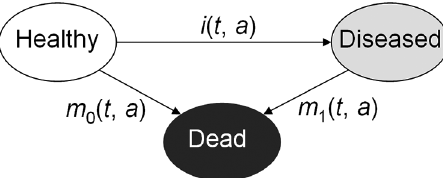
Figure 1. Illness-death model. People aged a at time t in the population are in one of the three states: Healthy , Diseased ,or Dead. Transitionsbetweenthesestatesaredescribed bytherates i , m 0 ,and m 1 ,whichingeneraldepend on t and a.